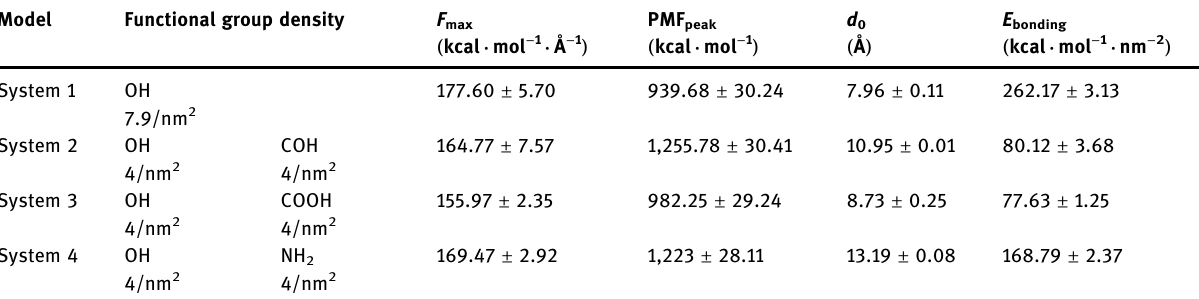
) , the PMF for debonding ( PMF max